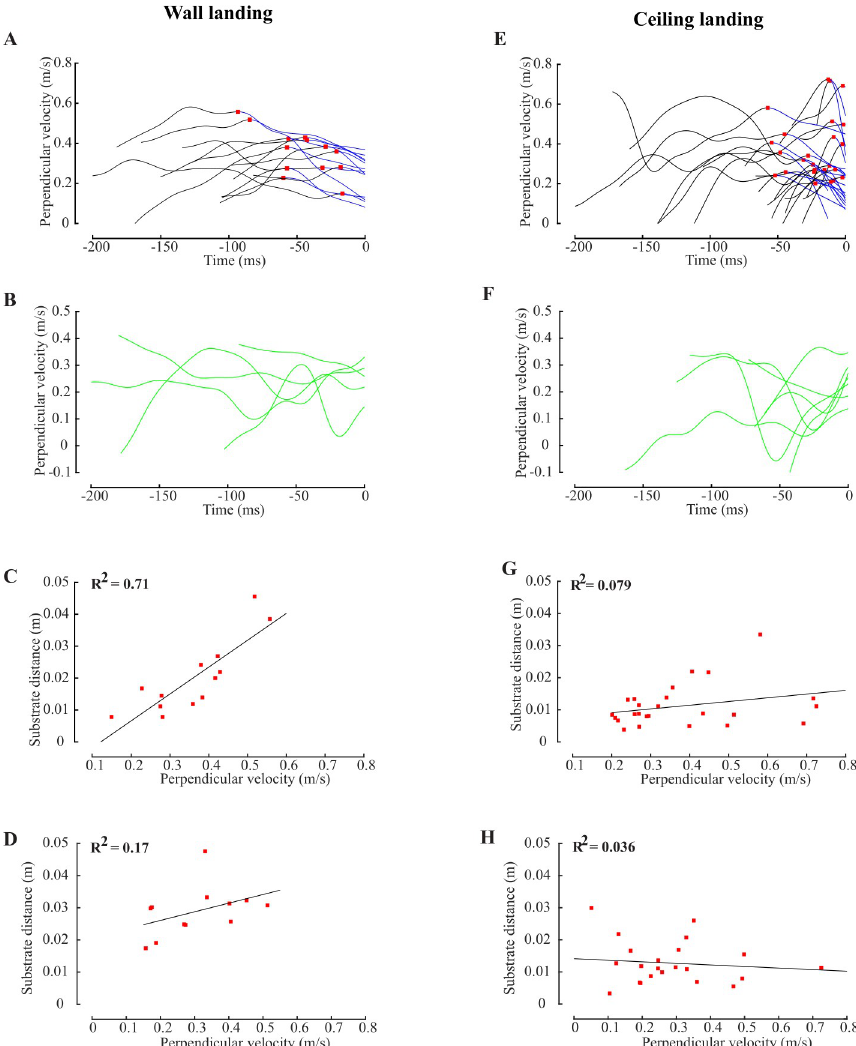
Fig 2. Initiation of deceleration and leg-extension during wall and ceiling landings. (A) Perpendicular velocity versus time-to-collision for all wall landings in which flies initiated deceleration before touchdown (n = 13). We identified the onset of deceleration (red squares, see Materials and methods) and decelerating segments of the flight trajectory (blue traces). (B) Perpendicular velocity versus time-to-collision for wall landings in which flies did not decelerate before touchdown (n = 5). (C) Substrate distance versus perpendicular velocity at the onset of deceleration for the 13 wall landings. Coefficient of determination (R 2 ) of the best-fit line is 0.71. (D) Substrate distance versus perpendicular velocity at onset of leg-extension for 12 wall landings in which onset of leg-extension could be identified (see Materials and methods; R 2 = 0.17). (E) Perpendicular velocity versus time for all ceiling landing trials in which flies decelerated before ceiling landing (n = 25). (F) Perpendicular velocity versus time for ceiling landings in which flies did not decelerate before touchdown (n = 7). (G) Substrate distance versus perpendicular velocity at the onset of deceleration for 25 ceiling landing trials (R 2 = 0.079). (H) Substrate distance versus perpendicular velocity at onset of leg-extension for 22 ceiling landing trials in which flies extended their legs while approaching the substrate (but not during take-off, see Materials and methods; R 2 =